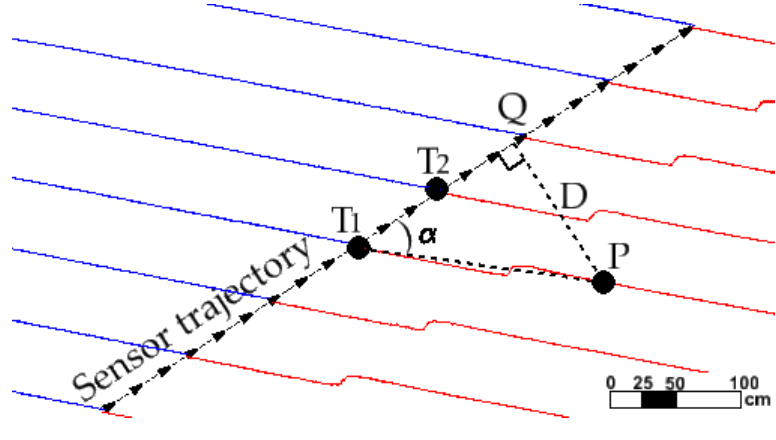
Figure 5. Trajectory distance scheme